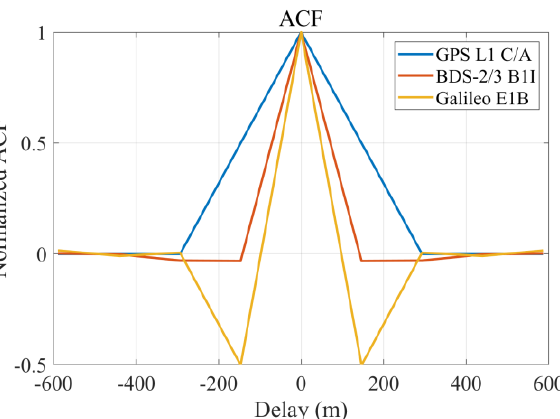
Figure 7. Auto-correlation function (ACF) of the GPS L1 C/A signal, the BDS-2/3 B1I signal, and the Galileo E1B signal.